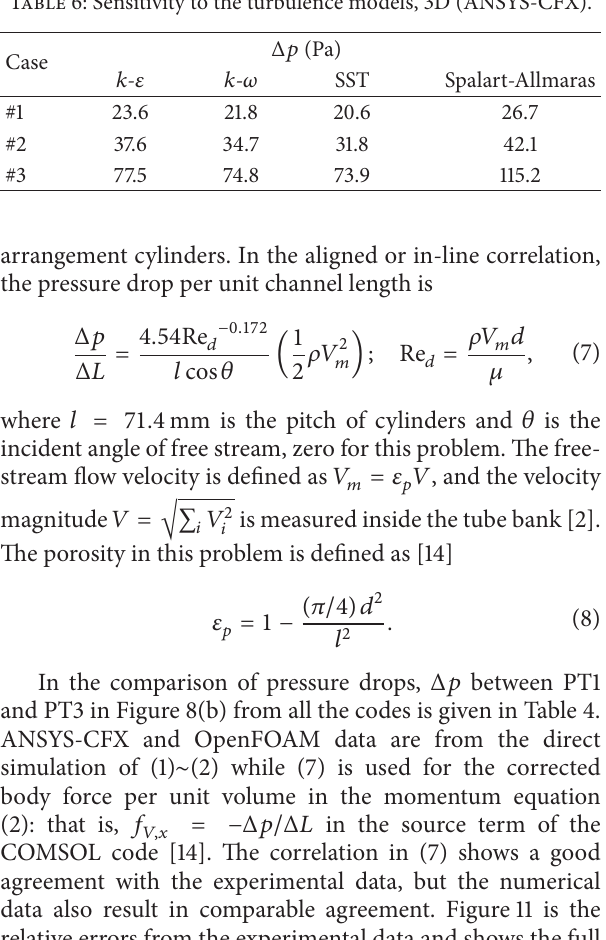
Table 6: Sensitivity to the turbulence models, 3D